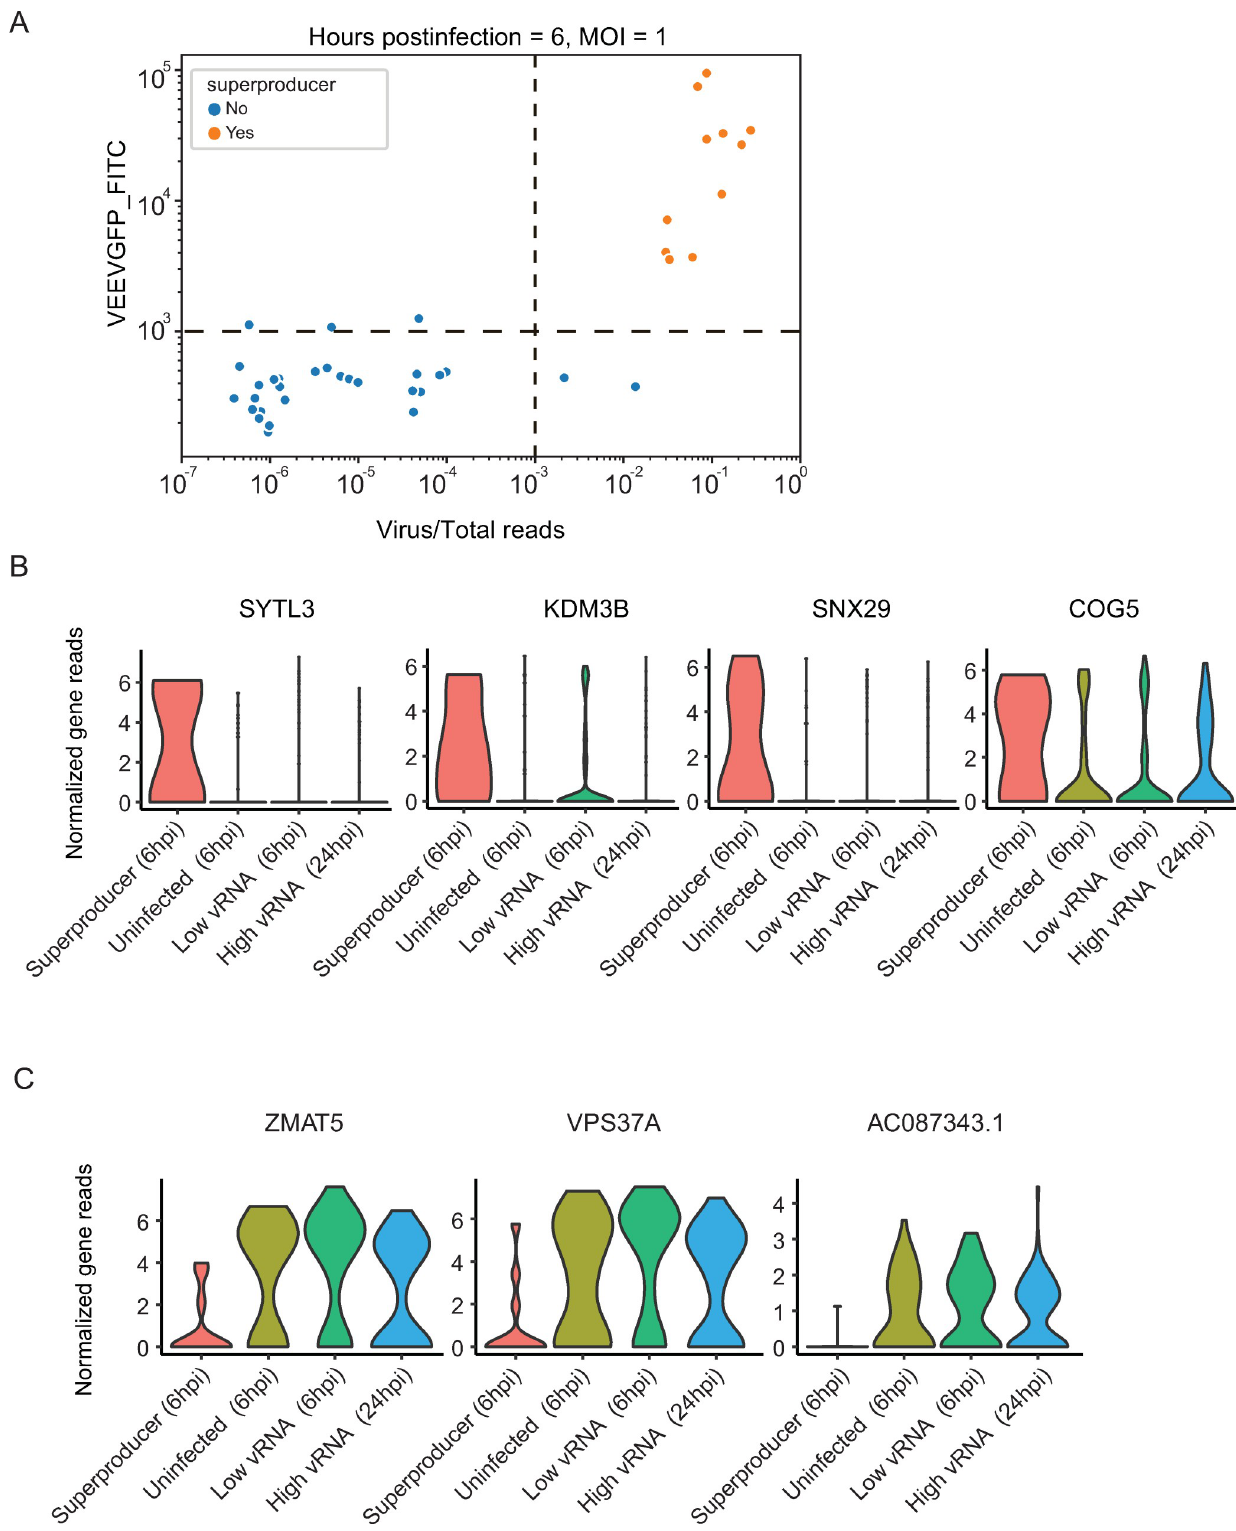
Fig 3. “Superproducer” cells exhibit altered gene expression patterns. (A) Scatter plot depicting GFP expression level and virus/total reads in cells at 6 hours postinfection (hpi) with VEEV- TC-83 at an MOI of 1. The horizontal and vertical dash lines indicate the cutoffs of GFP signal and virus/total read